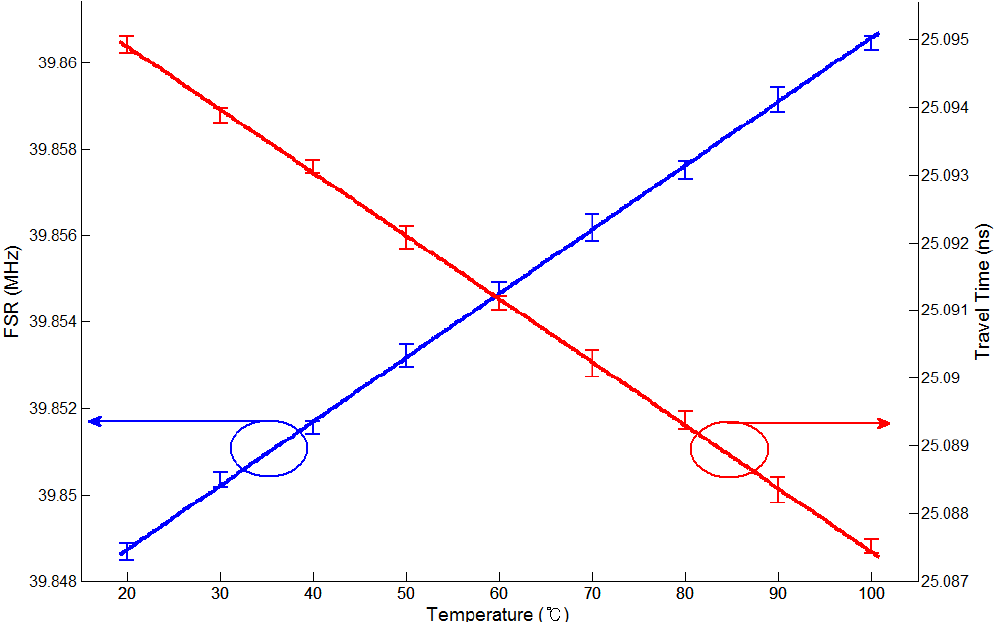
Figure 7. The FSR (blue line) and the travel time (red line) according to the temperature variation of the FBG sensor